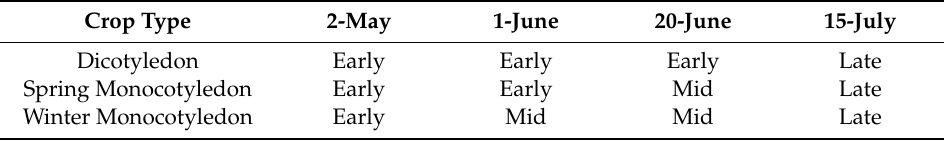
Figure 8. HLS-CCWC inversion results on 8 km by 8 km subsets of both Sentinel-2 and Landsat-8 HLS data for each inversion strategy (presented as columns). The inversions were performed during the 2016 growing season for May 2 (top), June 1 (second from top), June 20 (second from bottom), and July 15 (bottom) overpasses. The sensor during overpass as is labeled next to the date as S2 and L8 for Sentinel-2 and Landsat-8, respectively. The corresponding crop-type CDL land cover field boundaries are present on the right. Table 7. Phenological stages used for inversion strategies 2 and 3 for each crop type in Figure 8 images; early, mid, and late phenological stages correspond to emergence, establishment, and maturation.